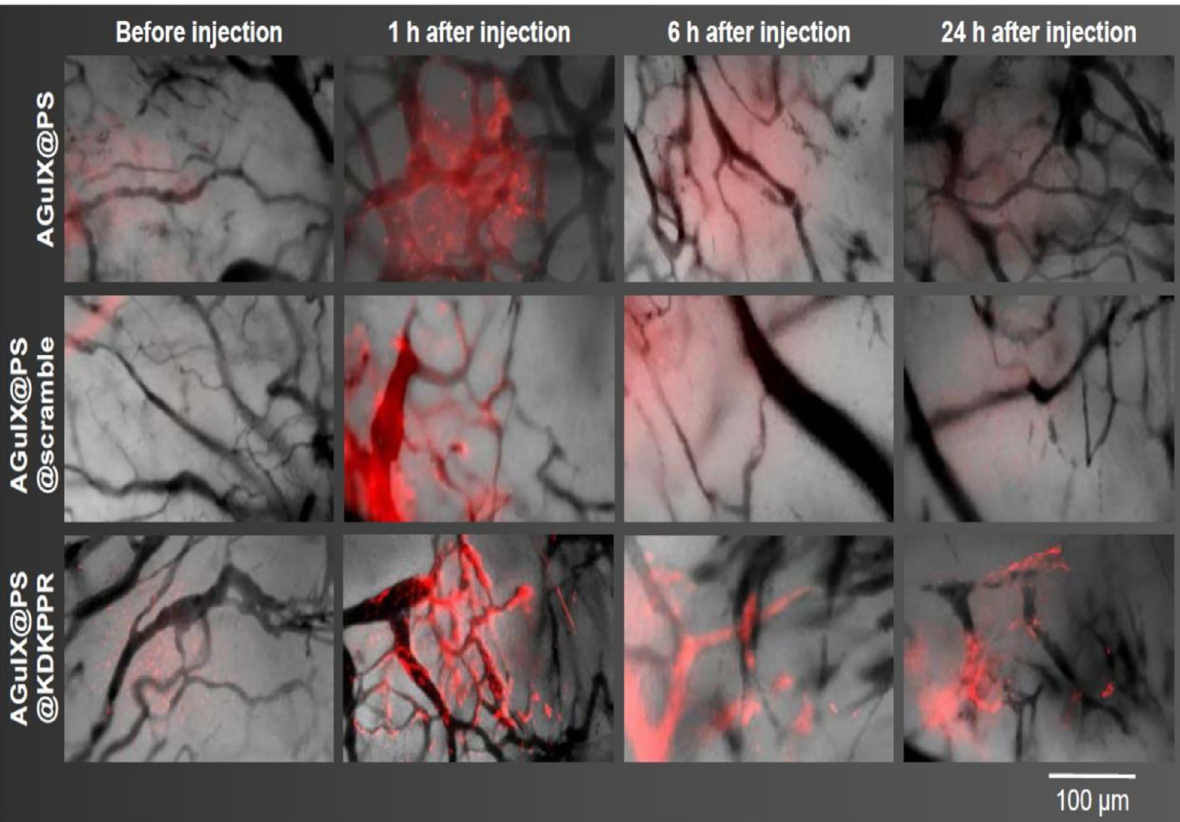
Figure5: Invivo selectivity:selectivityofNPsusinga dorsalskinfoldchambermodel,beforeand1, 6,and24hafterIV